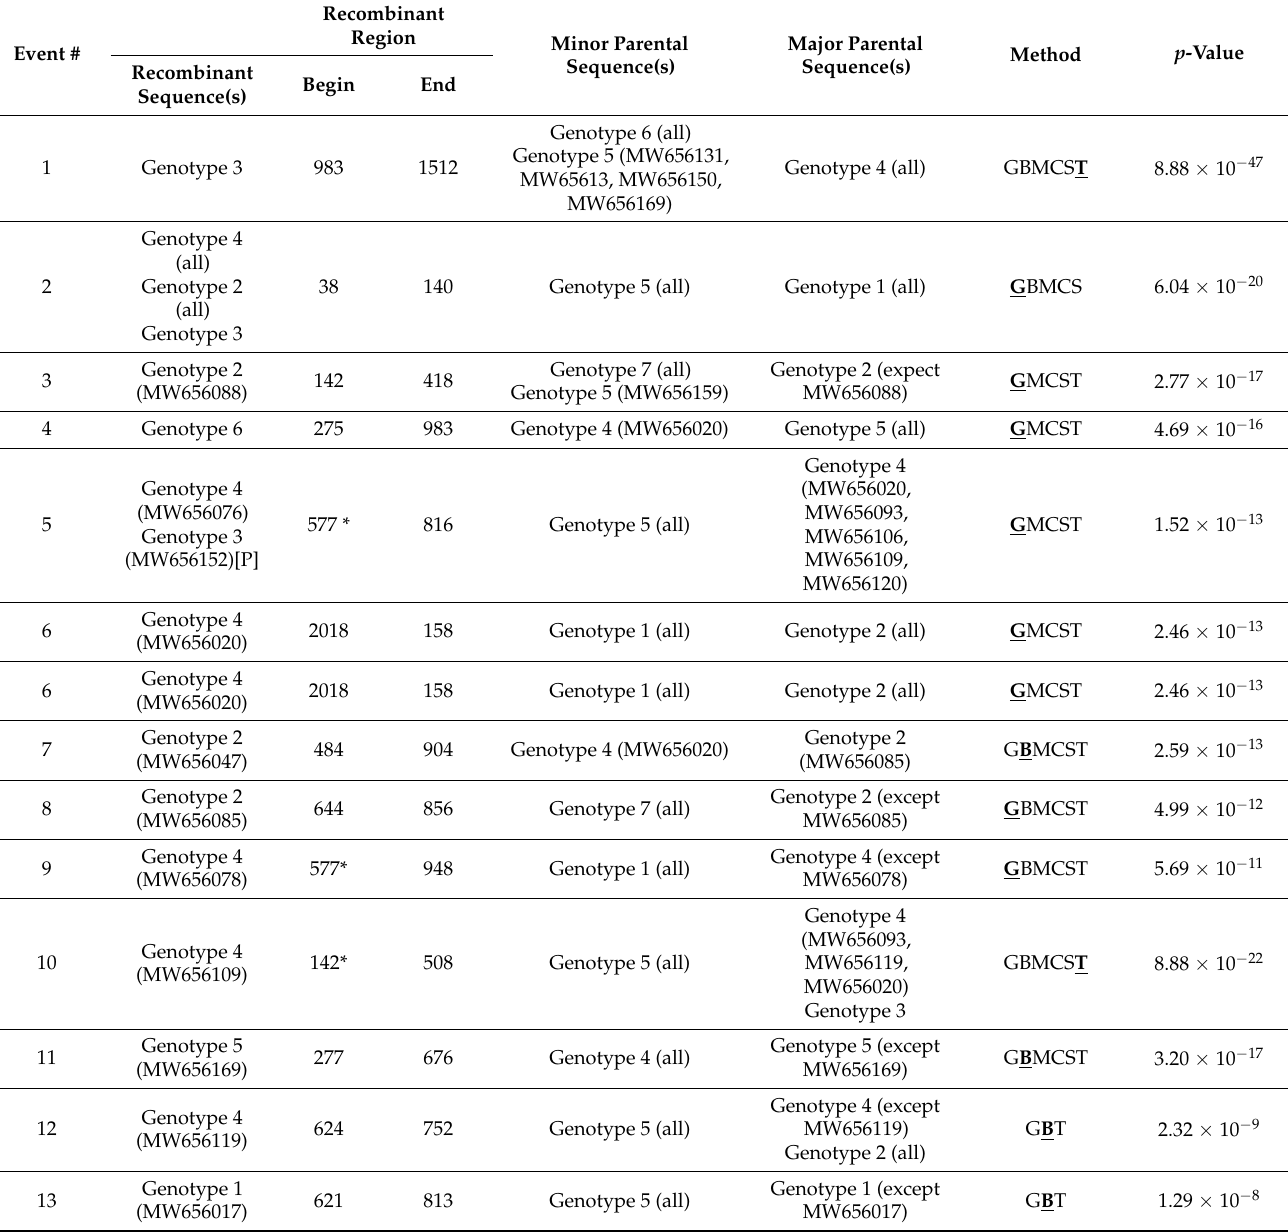
Table 2. A summary of the recombination events detected in the genomes of PiCV from this study. The methods used to detect recombination are RDP (R), GENCONV (G), BOOTSCAN (B), MAXCHI (M), CHIMERA (C), SISCAN (S) and 3SEQ (T). For each recombination event, the method with the highest p -value is in bold font and underlined. [P] denotes partial evidence of